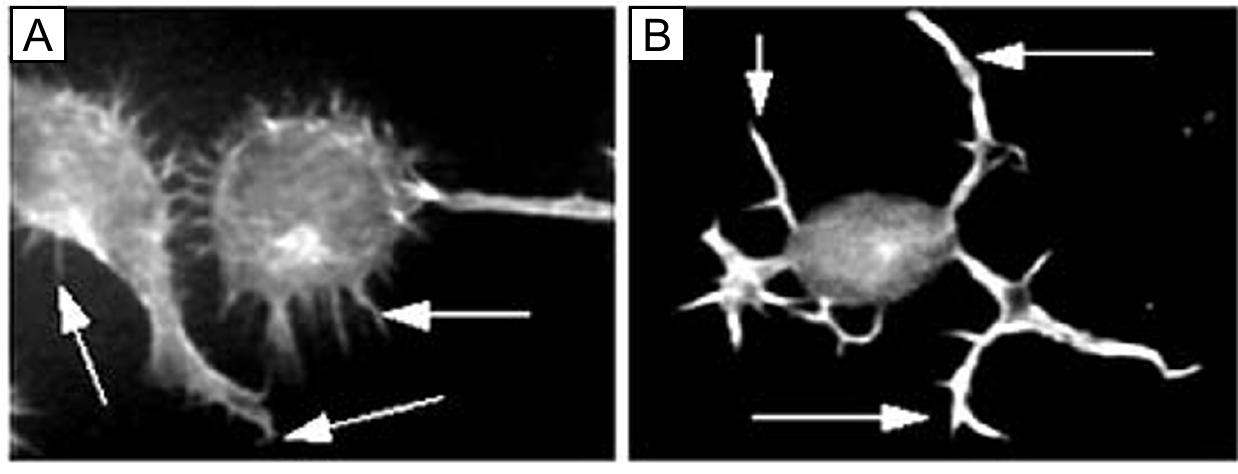
TRITC-phalloidin staining demonstrates that altered pseudopodia are enriched for filamentous actin. Cells were electropo- rated with control buffer (A), or electroporated with C3 (25 µ g/ml, B, C) and plated on VCAM-1 that had been immobilized on glass